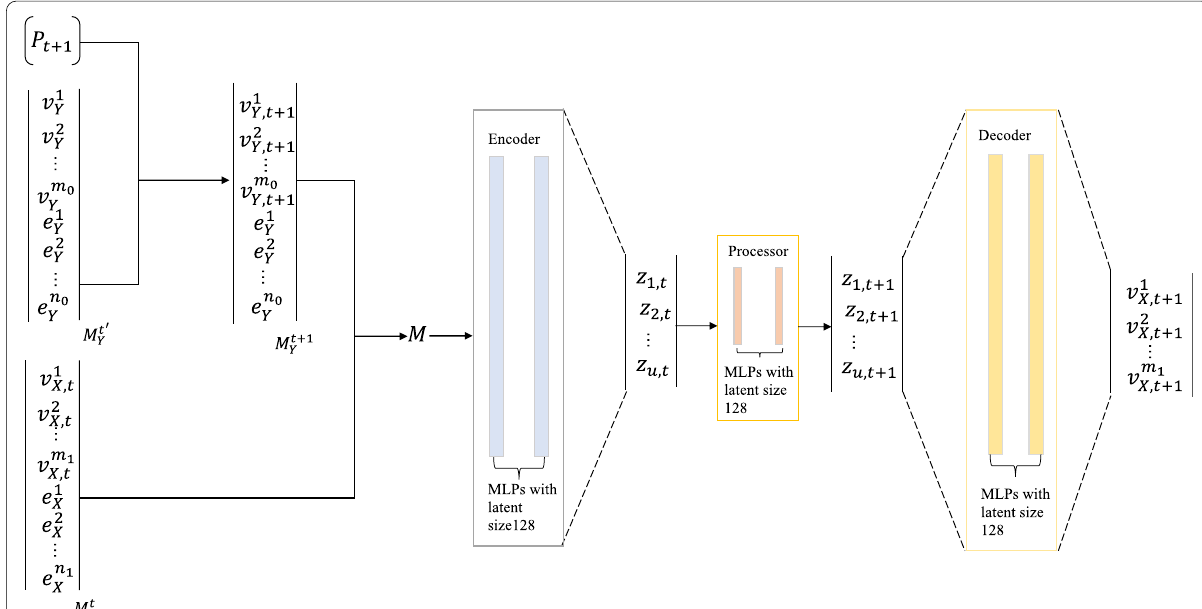
Fig. 2 The proposed network configuration. m 0 , m 1 , n 0 , and n 1 are the numbers of nodes and edges of the deformable object and tool. The encoder, processor and decoder have two latent layers with a latent size